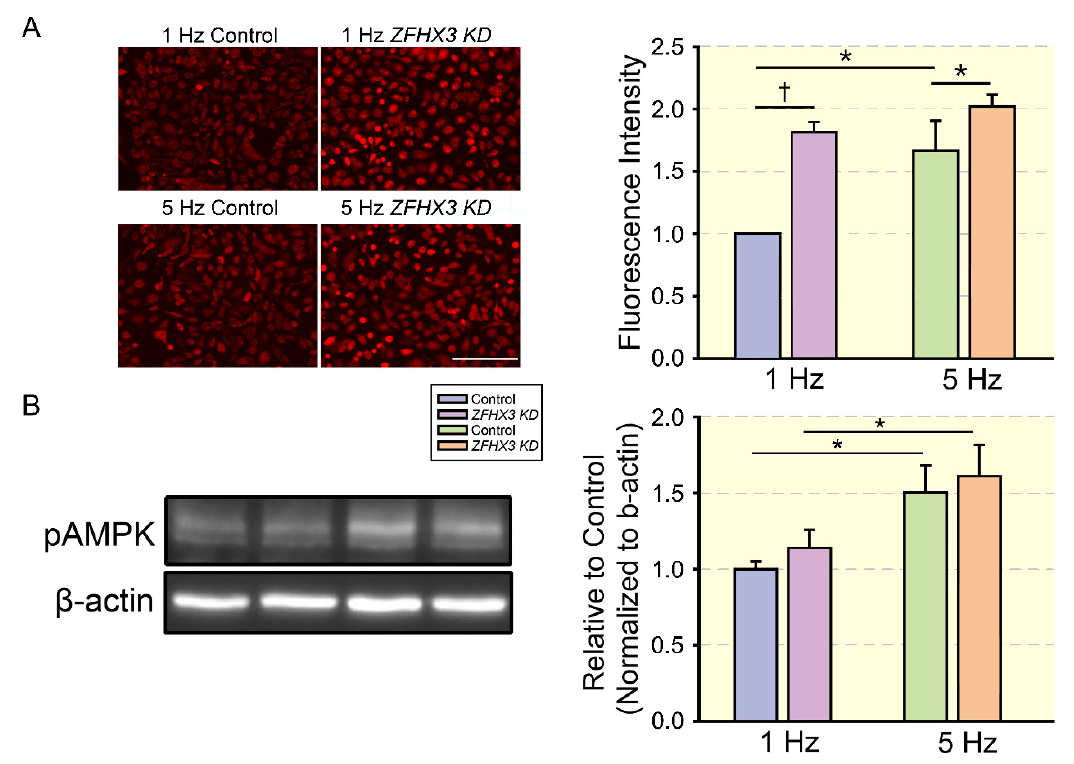
Figure 3. Effects of the tachypacing on pAMPK protein expression and mCa 2+ content . ( A ) Representative fluorescence and average data of microscopic images of control and ZFHX3 KD HL-1 cells under 1 and 5 Hz pacing ( n = 3 experiments per group). ( B ) Representative Western blot and quantified data revealed tachypacing caused a significant increase in pAMPK protein expression in control and ZFHX3 KD cells ( n = 5 experiments per group). * p < 0.05, † p < 0.01 (Reprinted/adapted with permission from Ref [68]. 2022, John Wiley &